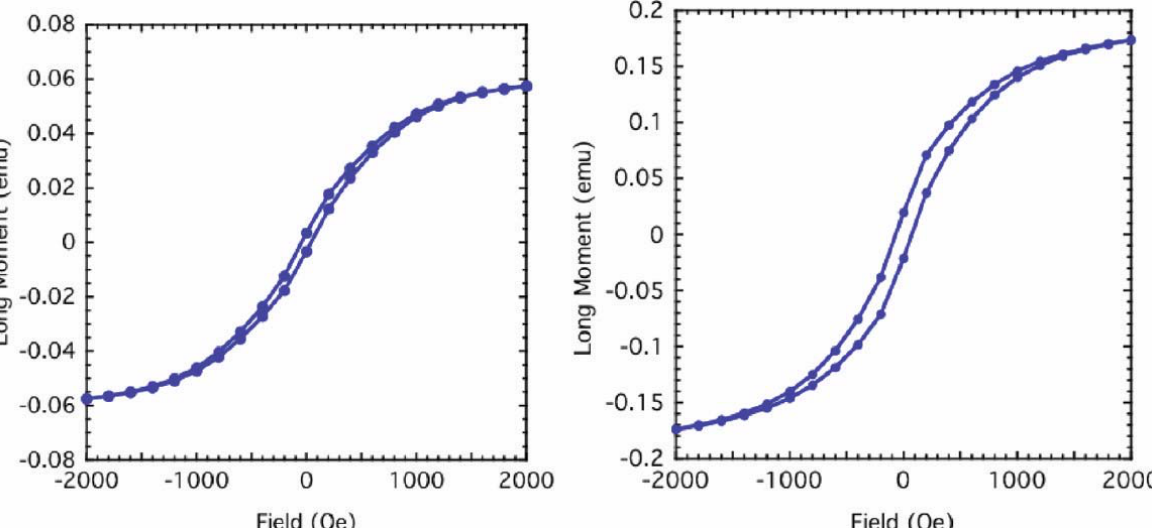
Si nanoparticle-containing product (left) and the 5 3